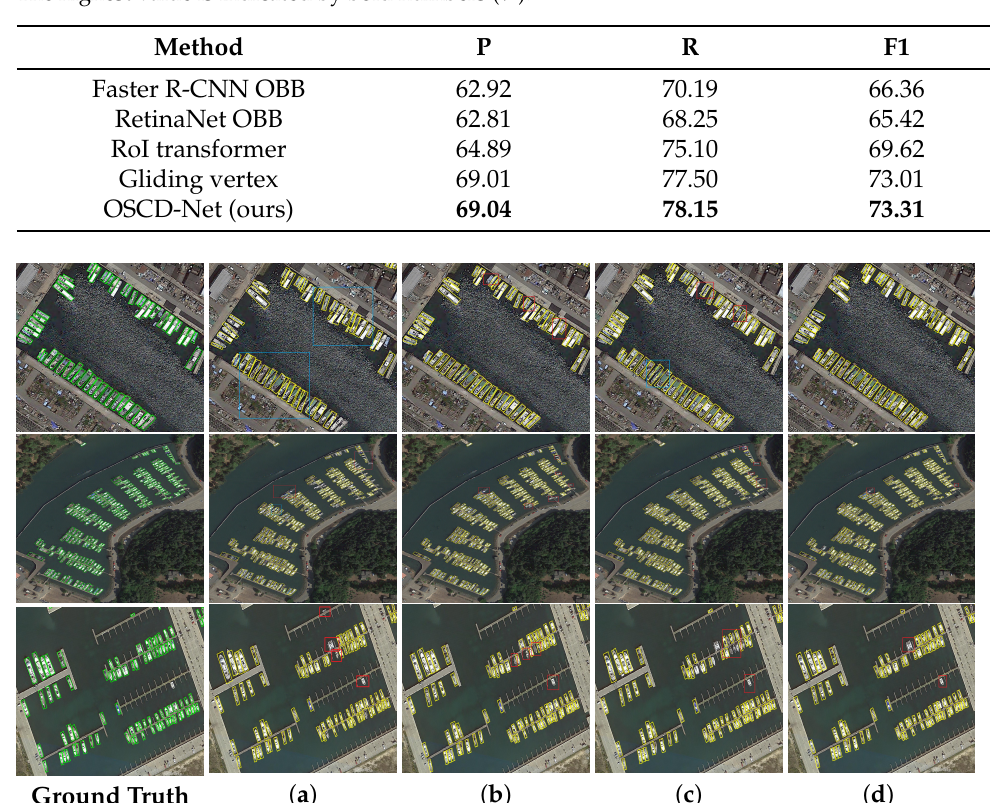
Figure 13. Comparison of experiment detection results on the DOTA-Ship dataset. The green box in the first column represents the ground truth. The yellow box indicates the detection result. The red box indicates the missed detection area, and the blue box indicates the inaccurate detection area. ( a ) The detection result of Faster R-CNN. ( b ) The detection result of RoI transformer. ( c ) The detection result of Gliding vertex. ( d ) The detection result of OSCD-Net.